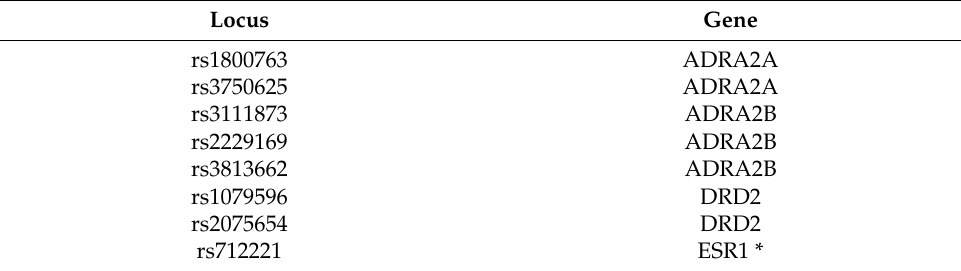
Table A1. The 19 Selected SNPs in the Present